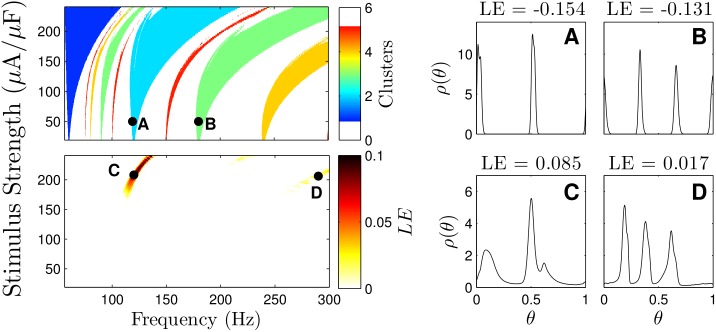
Clustered desynchronization and Lyapunov exponent calculations for thalamic neurons.The top-left panel shows regions of parameter space where clustered desynchronization is guaranteed for small enough noise. The bottom-left panel shows the regions associated with a positive average Lyapunov exponent (LE). Panels A-D give steady state probability distributions for stimulus parameters corresponding to black dots on the left.